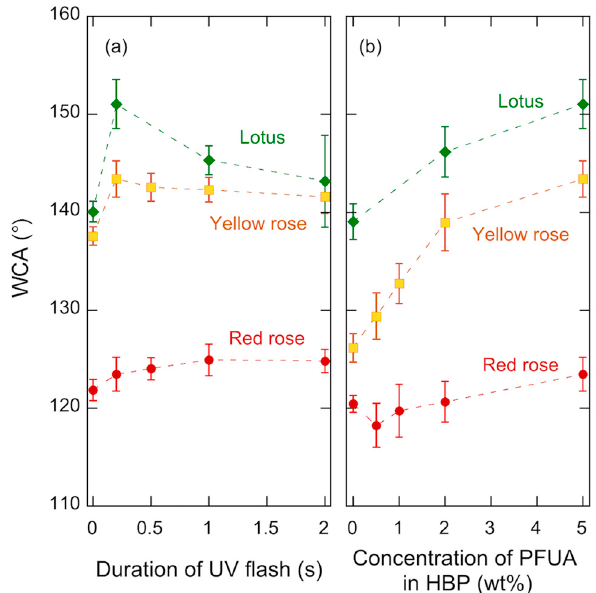
Figure 7. WCA of synthetic plant surfaces based on HBP + PFUA with 2 h of air exposure vs. ( a ) duration of UV flash prior to UVNIL for a 5 wt. % concentration of PFUA and ( b ) concentration of PFUA in HBP for a 0.2 s UV flash prior to UVNIL.